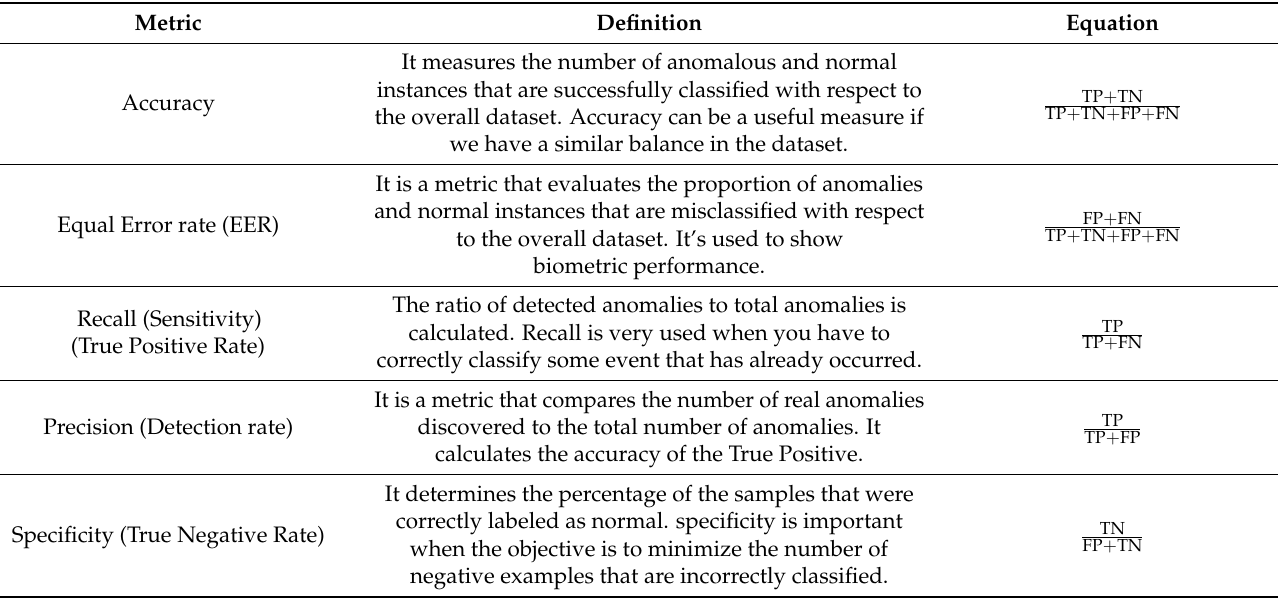
Table 3. Evaluation metrics used for AD approaches.